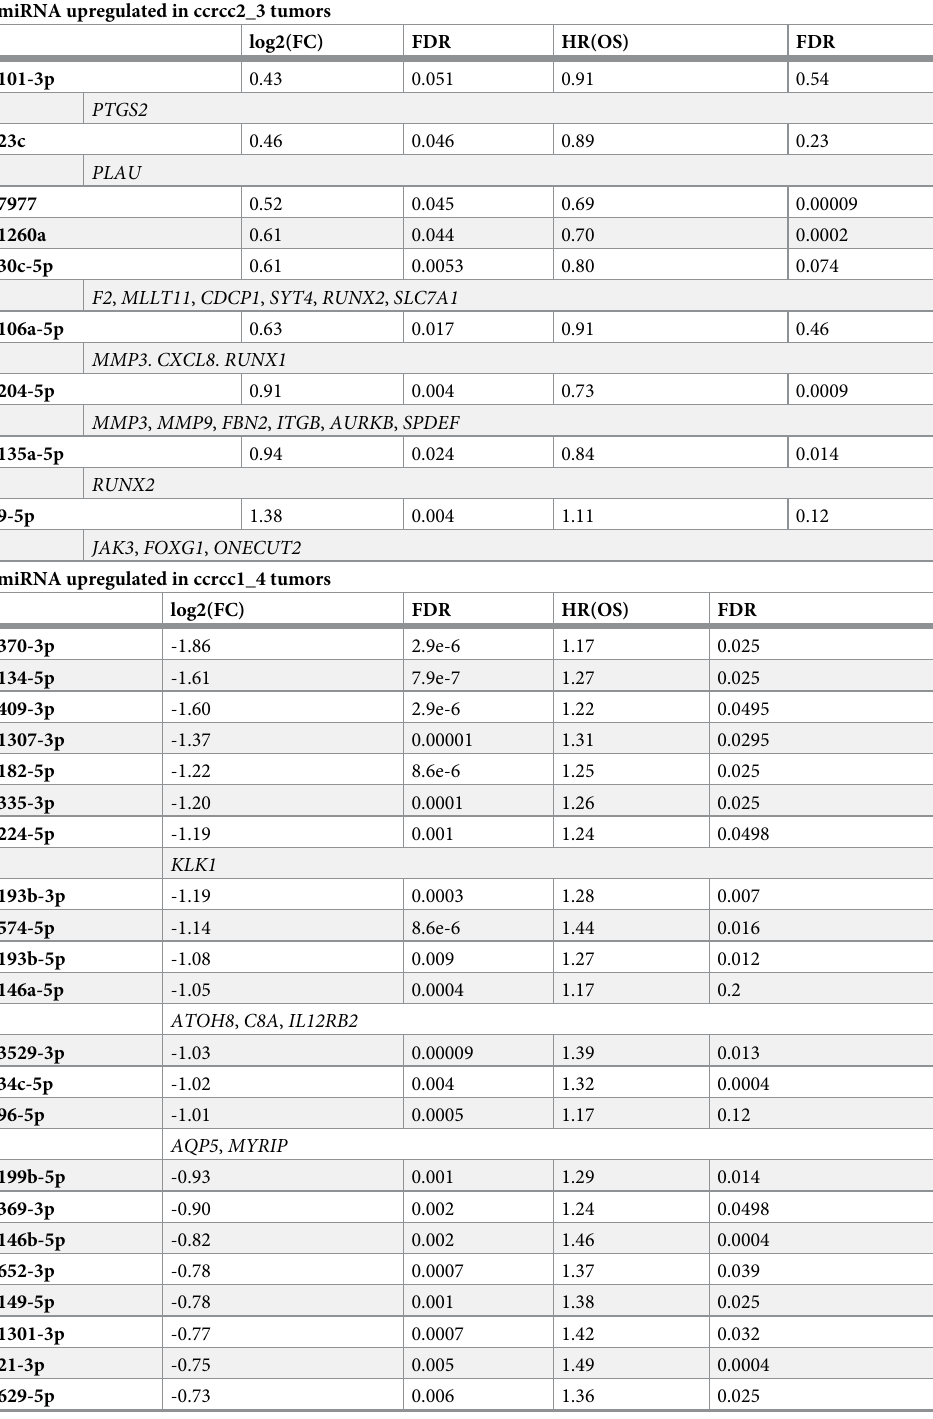
Table 2. List of miRNAs that exhibited subtype-specific expression (FDR < 0.05) and that were either signifi- cantly associated with OS (Leuven dataset) or suppressed an mRNA target that was downregulated with a fold change of < 0.5 compared to the other molecular subtype (TCGA dataset). miRNAs with higher expression in ccrcc1_4 subtypes were systematically associated with shorter OS, and those with higher expression in ccrcc2_3 with longer OS. Downregulated mRNA targets are listed below the miRNA. Only experimentally validated mRNA targets were considered (sources: TarBase, TargetScan Human, miRecords, Inguinity Expert Findings). mRNA subtype-spe- cific fold changes are illustrated in Fig 3B. miRNA upregulated in ccrcc2_3